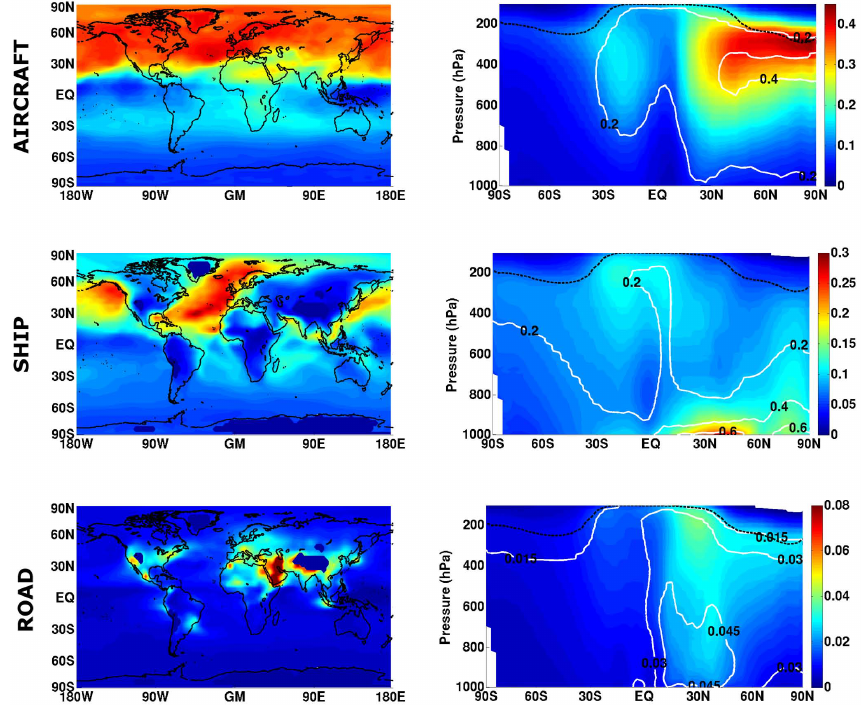
Fig. 2. Mean perturbations of ozone (ppbv) during July for the 2050 A1B scenario due to a 5% perturbation of aircraft emissions (top), ship emissions (middle), and road traffic emissions (bottom). The left column shows ozone perturbations in the upper troposphere (300–200hPa) for aircraft and in the lower troposphere ( > 800hPa) for ship and road traffic, while the right column shows zonal mean perturbations for each of these transport modes. In the right column, solid white contour lines show the percentage change relative to the BASE simulation while the dashed black line indicates the tropopause. Note that different scales have been used for each of the traffic sectors and that the scales have been reversed in order to show O 3 reductions, arising from a 5% decrease in emissions, as positive